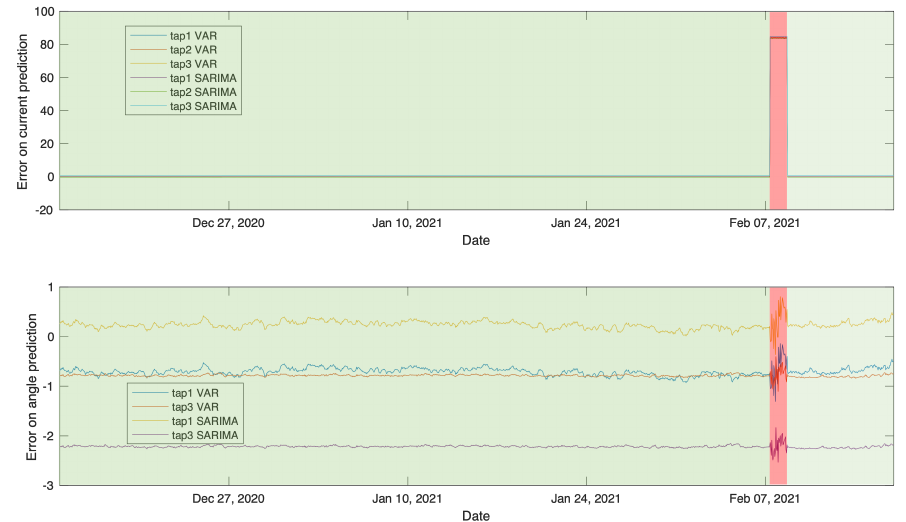
Figure 10. VAR and SARIMA rolling error between predicted and actual test